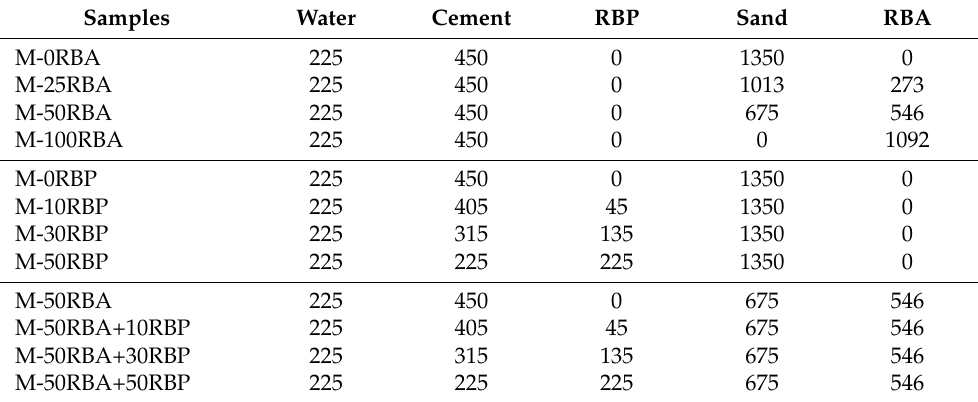
Table 3. Mix proportion of cement mortar with RBA and RBP (kg/m 3